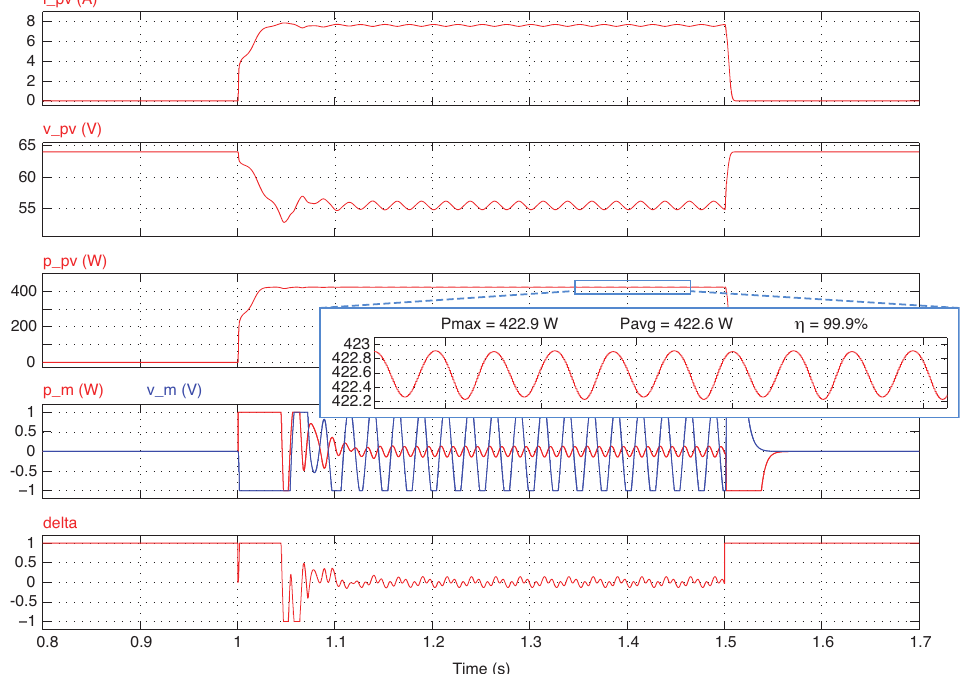
Figure 13. Simulated transient response against current reference steps. The power alternates between zero and the MPP—from top to bottom: i pv , v pv , p pv , p m , v m and δ . Equation (29) in steady-state results i L